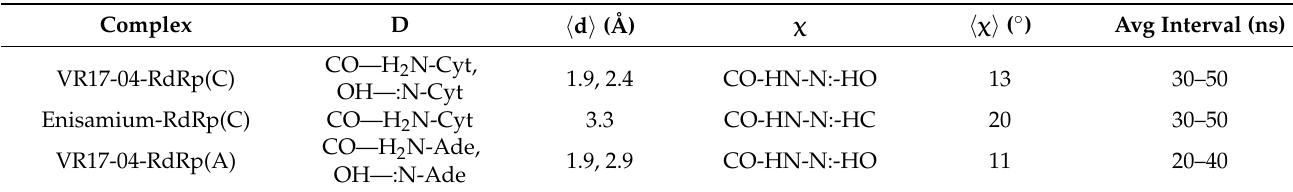
Table 3. Structural characterization of the interaction (Watson–Crick base pair) between VR17-04-cytosine (Cyt), enisamium- (Cyt), and VR17-04-adenine (Ade), described by average distances (cid:104) d (cid:105) between hydrogen bond donor and acceptor groups, and average values of the coplanarity angle (cid:104) χ (cid:105) . The errors on the mean values are smaller than the last decimal digit. The selected distances and dihedrals are defined by the atoms in bold. The average interval is reported.